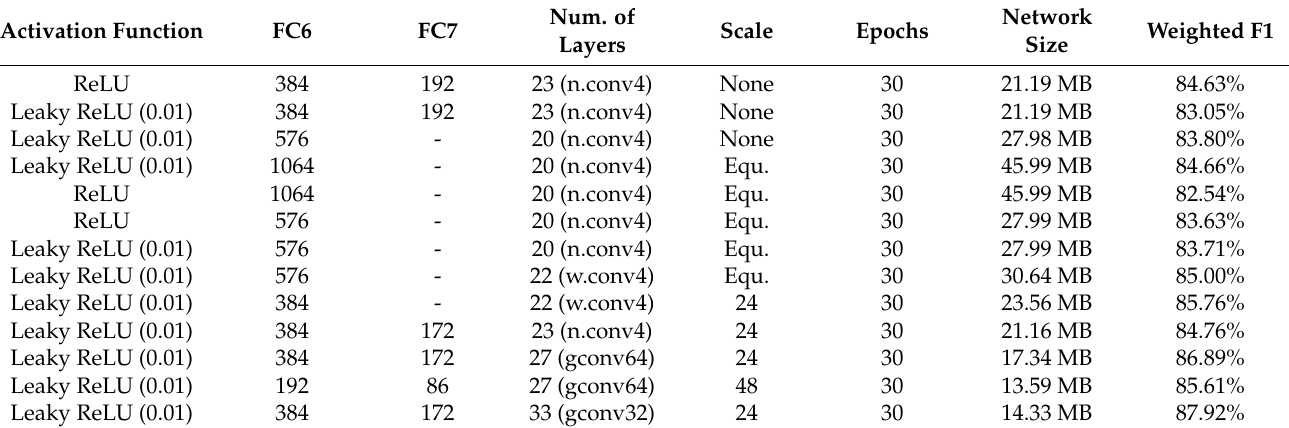
Figure 7. Training accuracy and losses graph ( Left ) AlexNet; ( Right ) Modified AlexNet with less parameters. Table 8. Results for the combination of layer and parameter